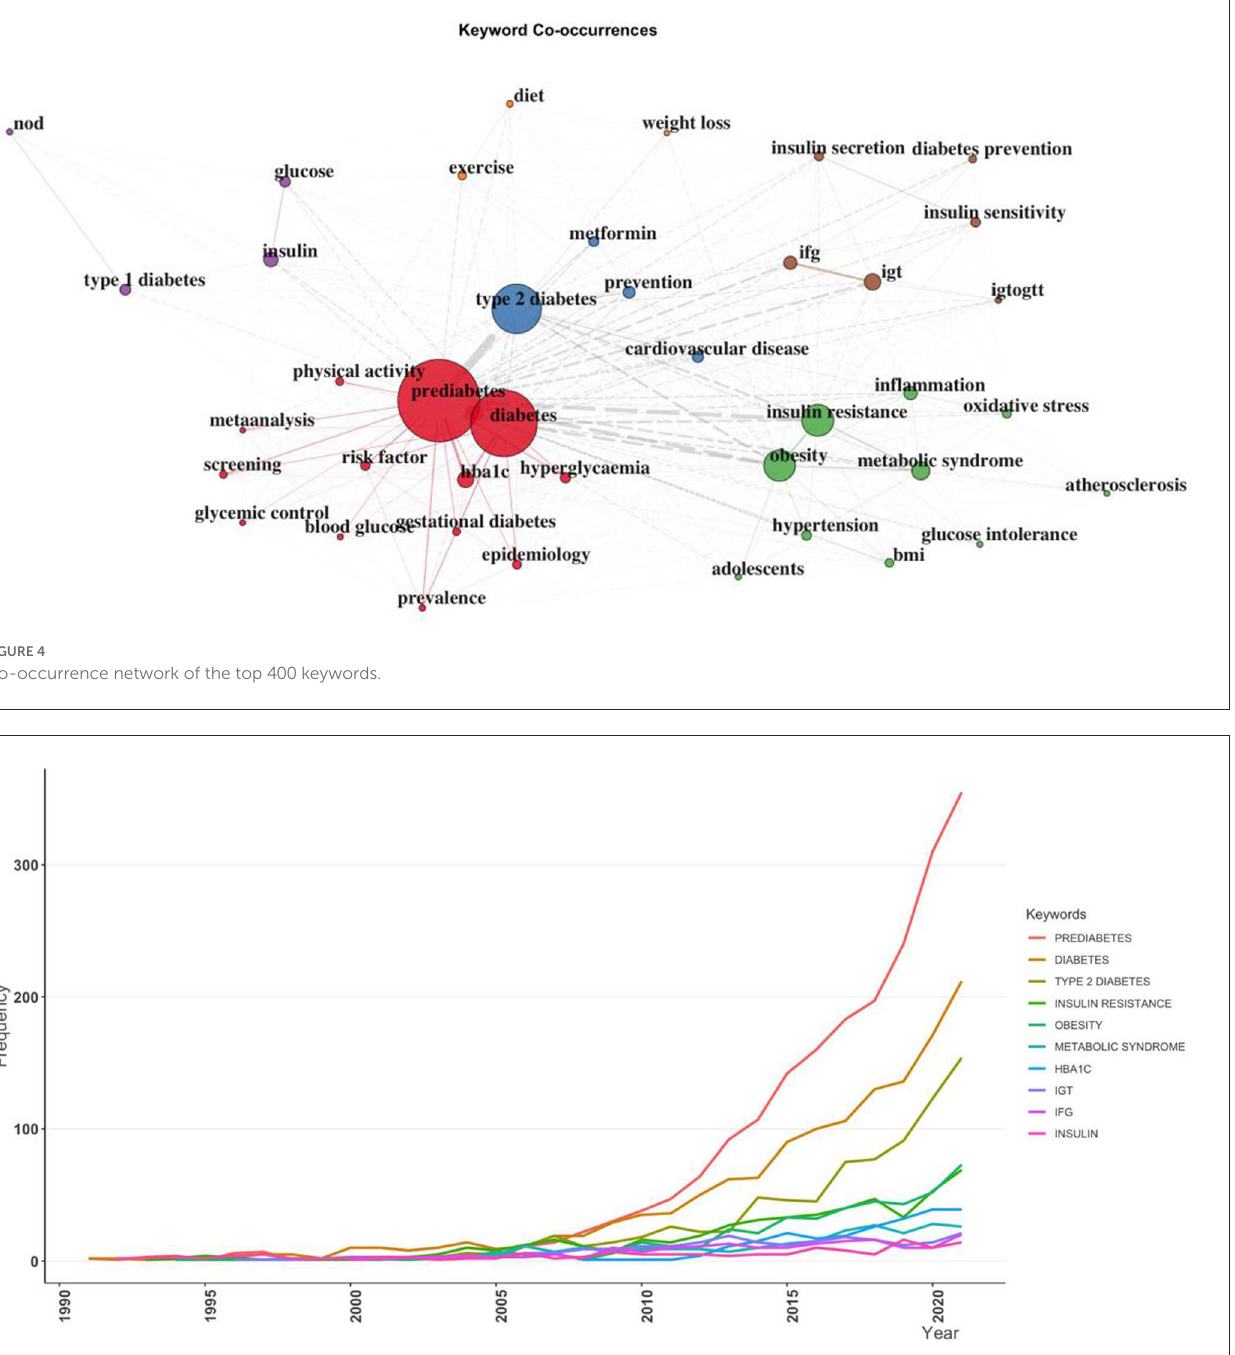
FIGURE5 Growth trend of the top 10